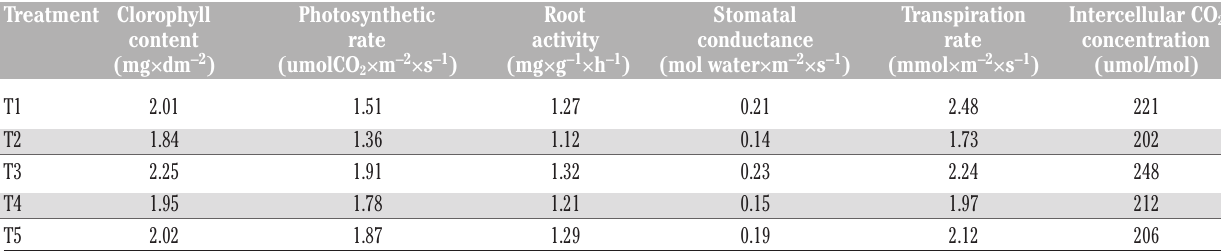
Table 3. Different treatments effect the physiological growth parameters of marigold seedlings. Treatment